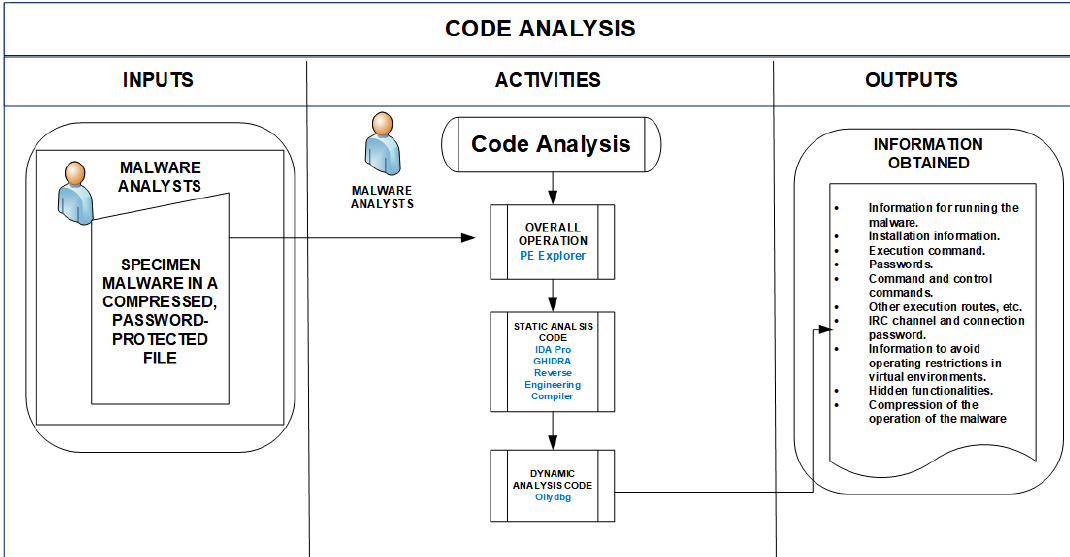
Figure 7. Diagram of the code analysis step.